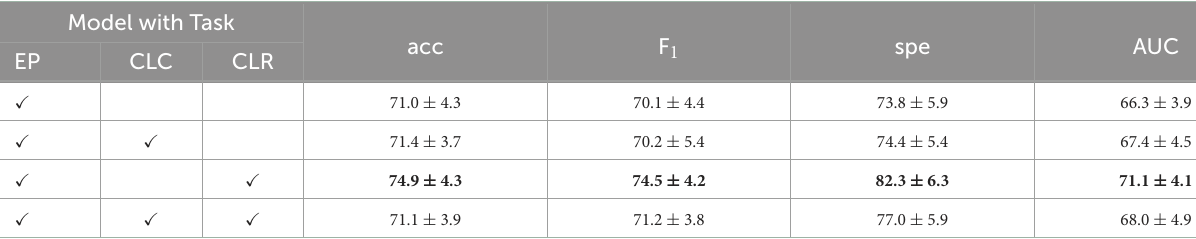
TABLE 4 EP classification performance of our model when introducing different cognitive estimation subtasks, using GM images as input. Model with